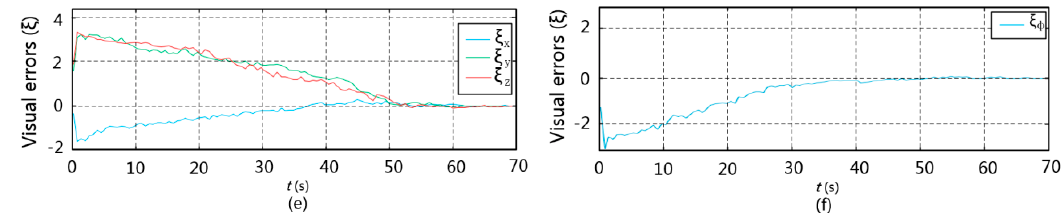
Figure 13. Visual errors of experiment B.